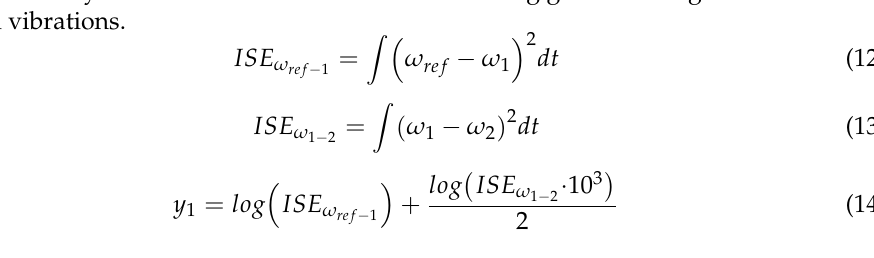
Figure 7. Transients of difference between motor and reference speed for analyzed controller cases. Figure 8. Transients of motor, load and reference speed for analyzed controller cases.